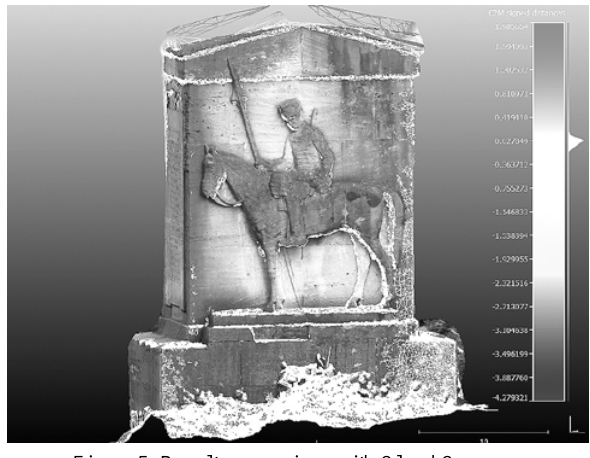
Figure 5: Result comparison with Cloud Compare Mesh processing software like MeshLab and 3D printing tools have to be applied at the end of the working chain.